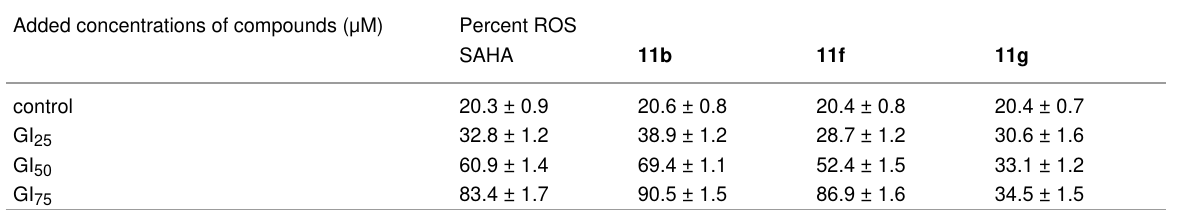
Table 4: Comparison between quantitative assays of ROS a generation induced by four compounds by DCFH-DA in HeLa cells through flow cyto- metric analysis. Added concentrations of compounds ( μ